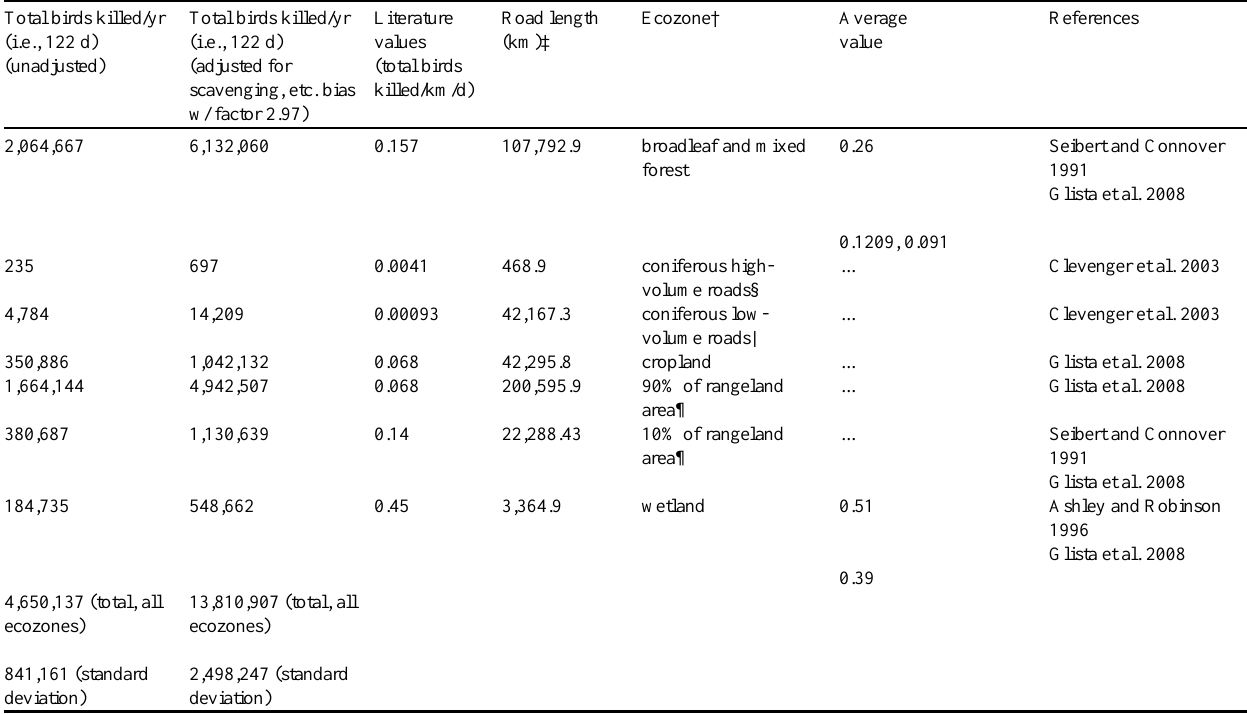
Table 3 . Total birds estimated to be killed annually by collisions with vehicles on 1- and 2-laned paved roads in Canada, outside major metropolitan